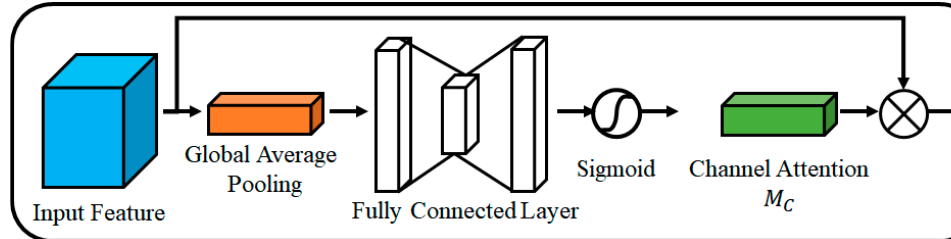
Figure 9. Channel Attention Structure.